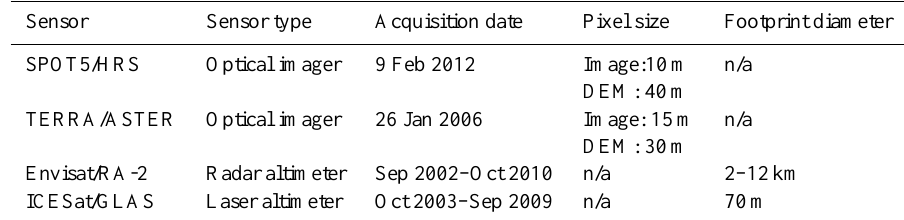
Table 1. Description of the various remote sensing products used in this study.